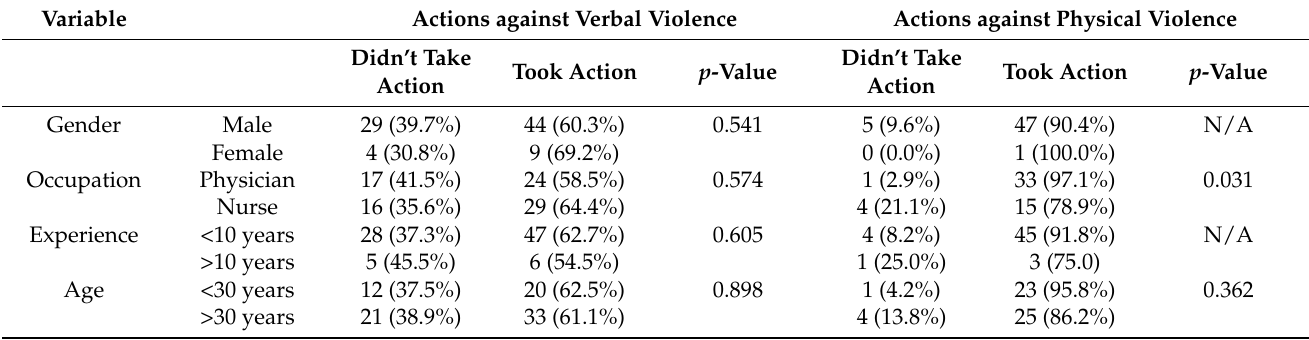
Table 4. Factors affecting propensity to take action against workplace